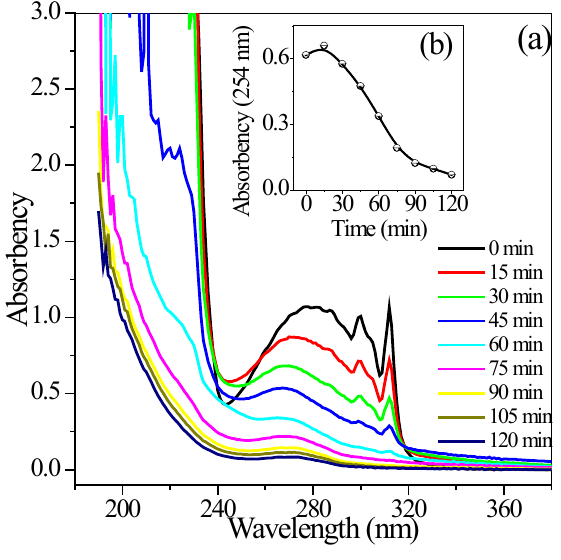
Figure 4. Absorbance curves ( a ) and UV = 40 mg/L, T = 290 K, flow rate = 0.35 L/min, pH = 6.7, and the maximum C 0 irradiation